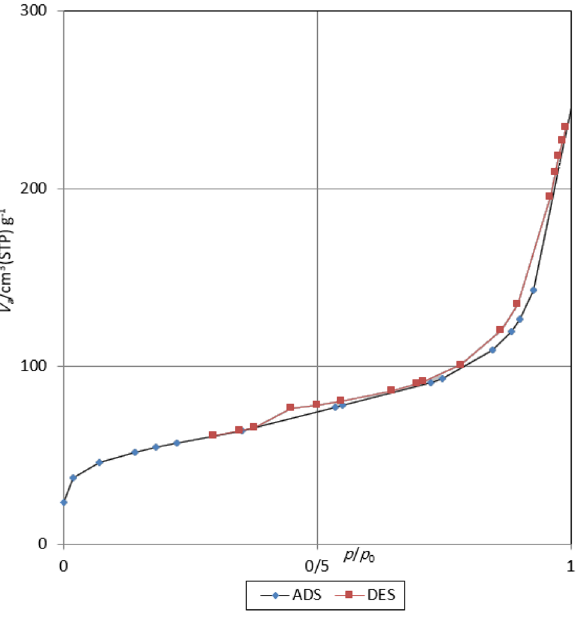
Figure 7. BET isotherm of the mesoporous Fe 3 O 4 @PMO-ICS-ZnO nanocatalyst ( 1 ).